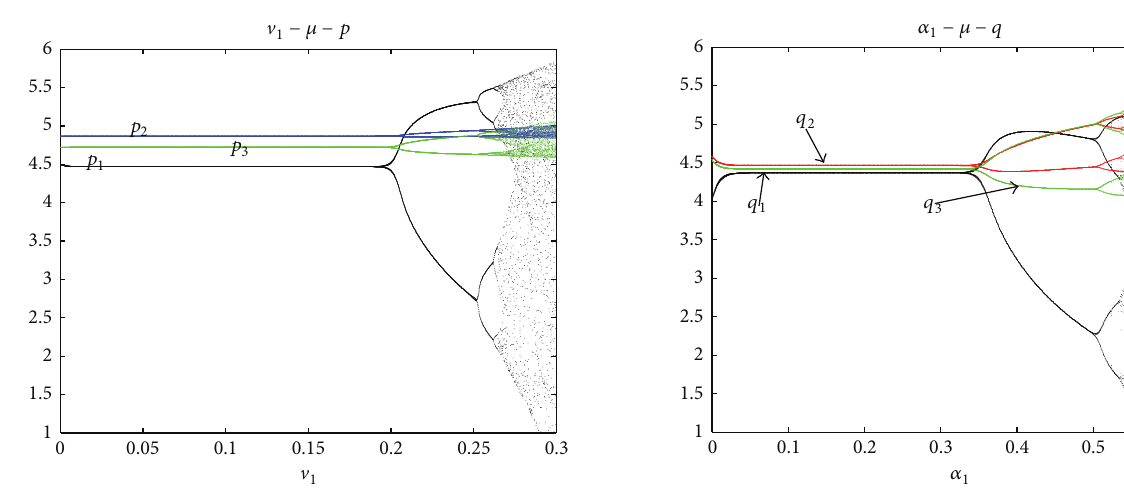
Figure 14: Track of 𝑝 𝑖 with V 1 after adjustment.